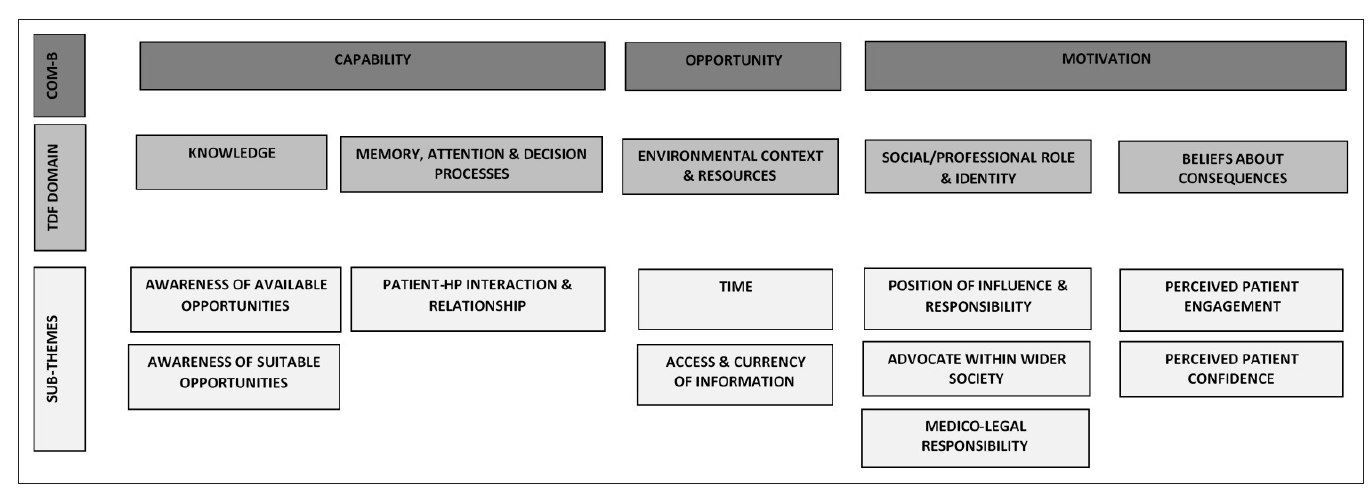
Figure 2 HP barriers and facilitators to connecting patients to community- based physical activity opportunities COM- B = capability, opportunity, motivation, behavioural model. HP = health professional. TFD = theoretical domains